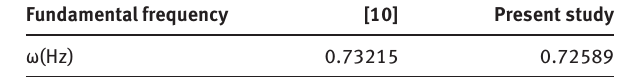
Figure 3 Effect of the shell aspect ratio on the fundamental frequency for simply supported square laminated spherical